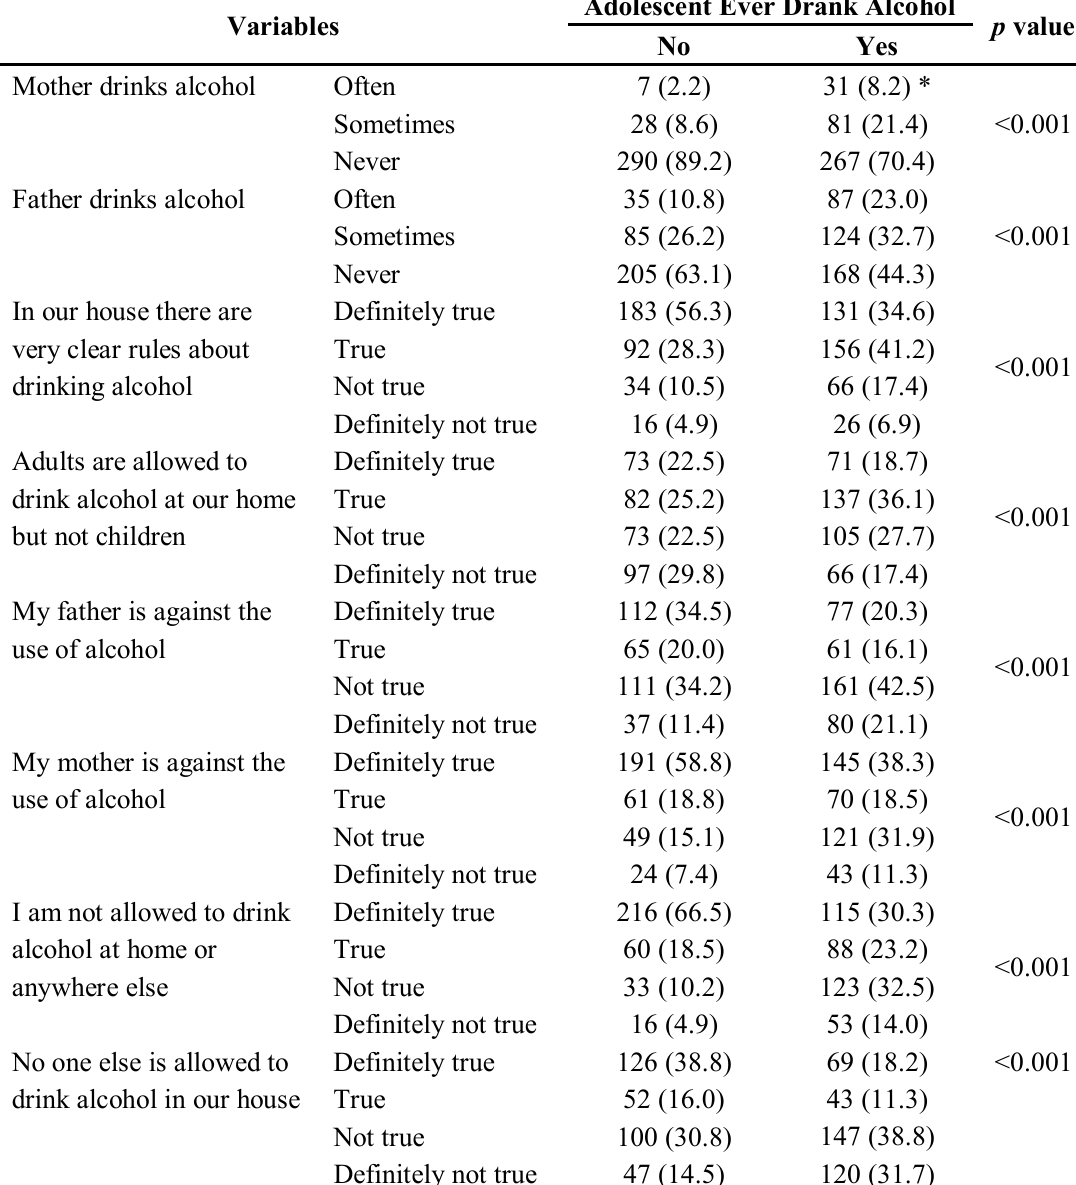
Table 4. Adolescent’s perception regarding their parents’ alcohol uses and house rules regarding alcohol